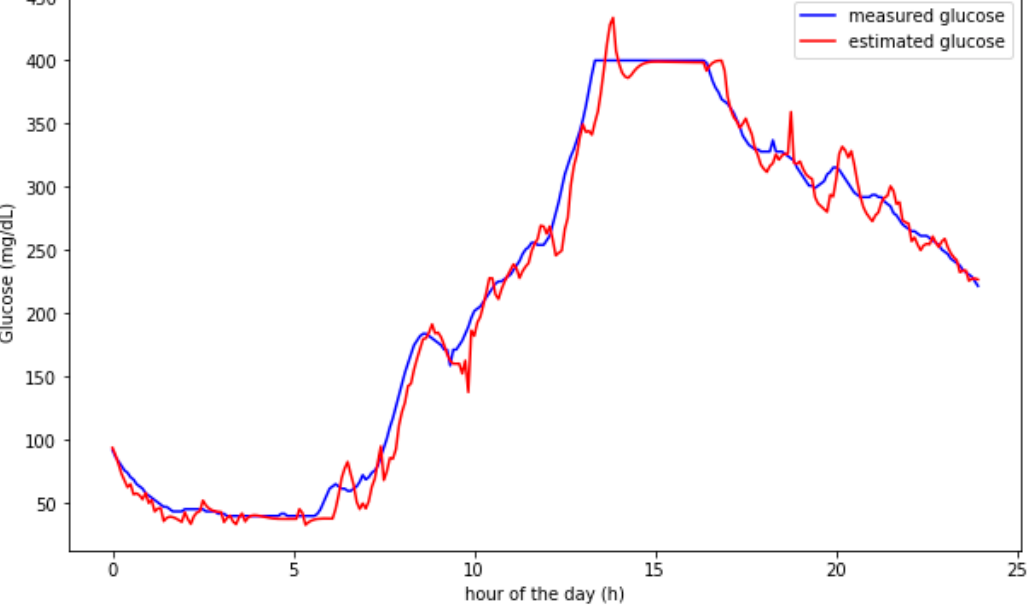
Sensors 2020 , 20 , x FOR PEER REVIEW Figure 8. Predictions on a 30 min horizon for a single day for a real participant.